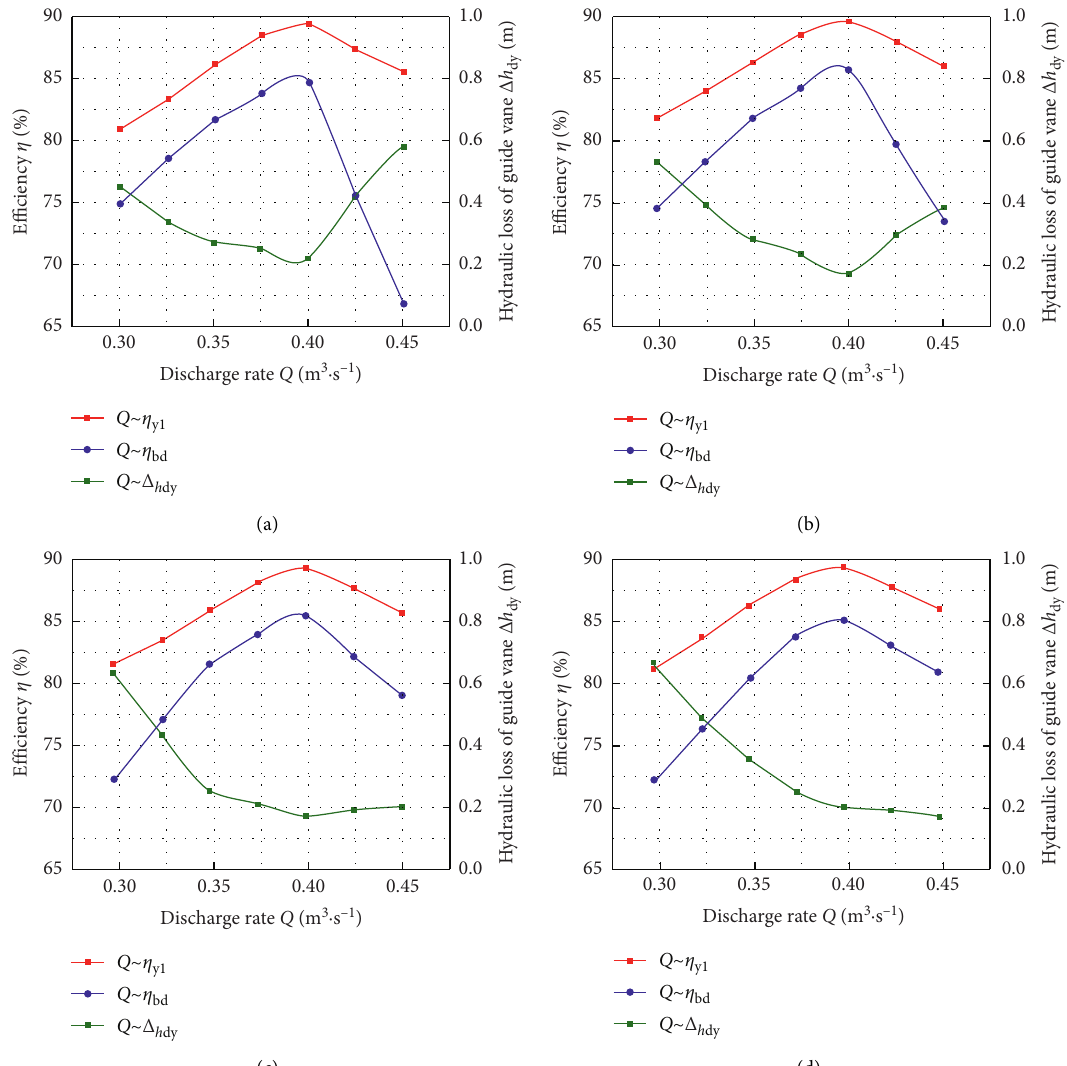
h values. (a) h � 0.10 H , (b) h � 0.20 H. (c) h � 0.25 H , and (d) h � 0.33 H